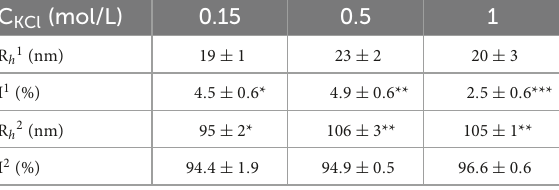
TABLE 1 Summary of dynamic light scattering (DLS) assessments of paramyosin under three salt concentrations. C KCl (mol/L) 0.15